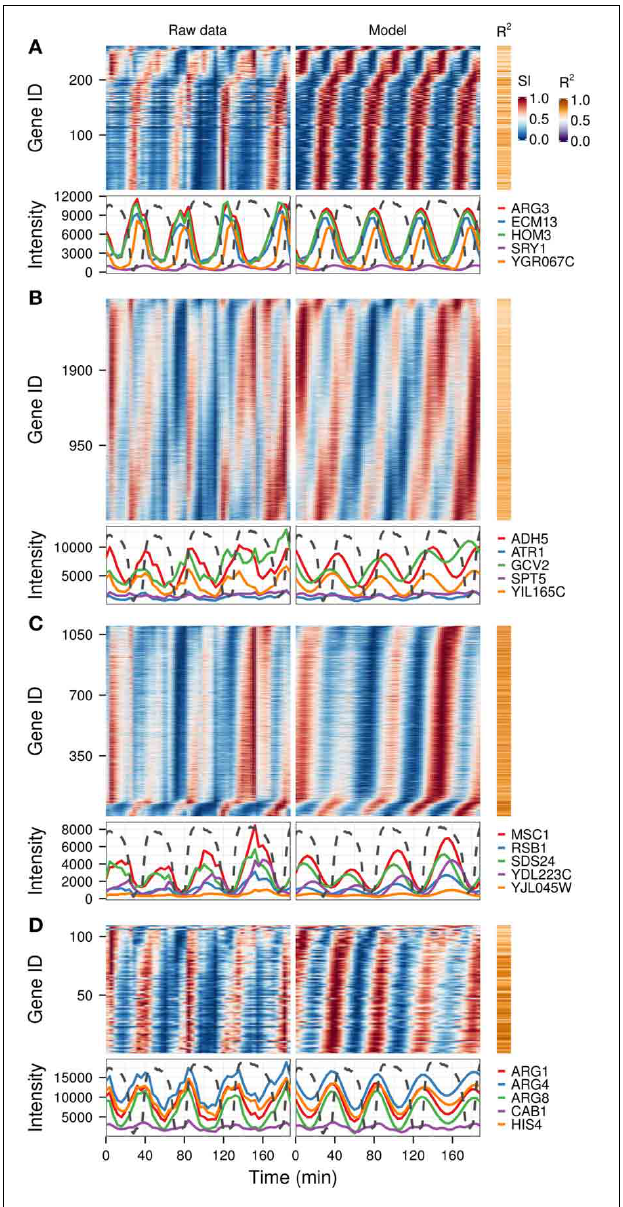
FIGURE 4 | Identification of differential responses to perturbation. Based on the analysis presented in Figure 3 , four gene cohorts with differential responses were identified based on the presence of the spectral components of interest (1, 3, 4, 5). Genes showing a 4-cycle oscillation and no period drift (no 3 and 5 components) were separated into genes with no major trend over the experiment (A) , and those that had a response to the experiment (B) . Genes with 3-cycle (C) and 5-cycle components (D) are shown separately. The top 5 genes with the highest R 2 in each cohort are shown in the bottom panel of each graph, against the corresponding dissolved oxygen (DO) trace (dotted lines), which was scaled to the range of the plot. The perturbation agent (phenelzine, 1mM) was injected at min 48. The temporal profile of each gene was scaled (SI) for visualization purposes.